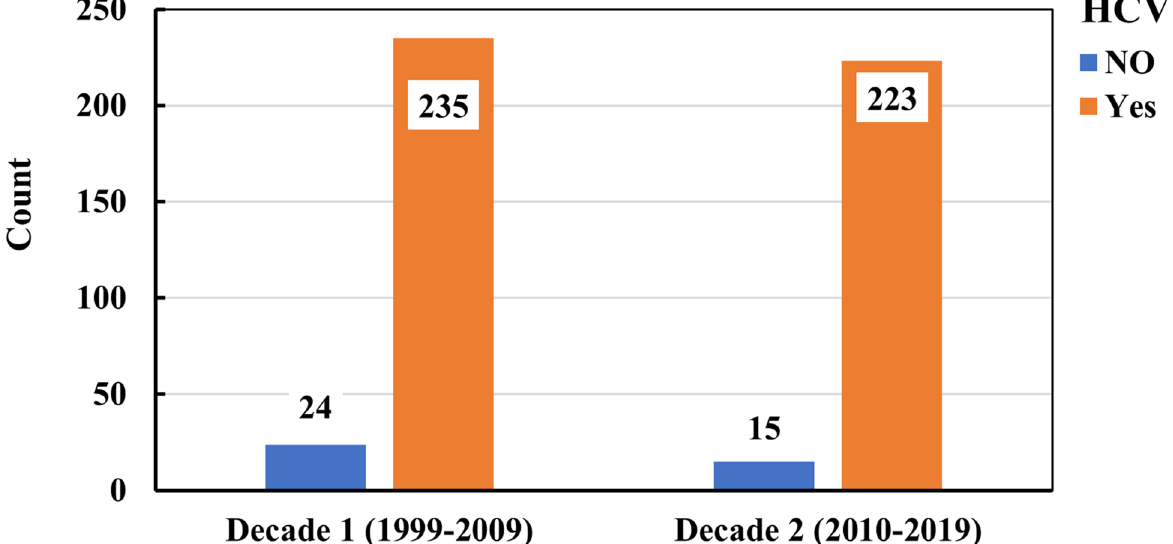
Fig. 10 Comparison between the 1 st and 2 nd decade regarding cases with positive HCV antibody Fig. 10. This chart showed that, anti –HCV AB was 235 cases (90%) in the 1st decade and 233 cases (93%) in the 2 nd decade with no statistically difference between two decades ( P value